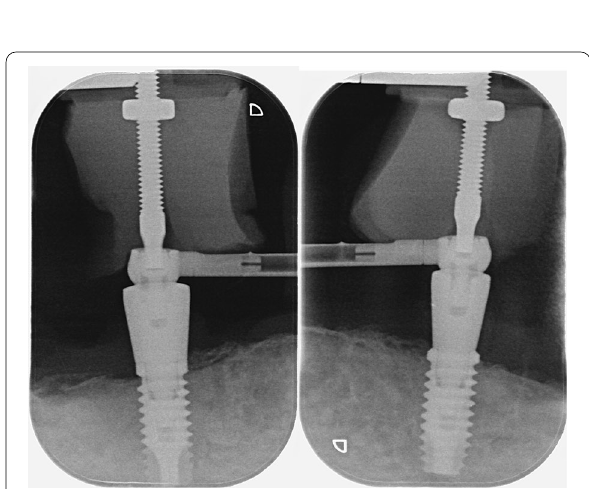
Fig. 5 Exemplary radiograph of the implant group BL‑SIC (SIC invent AG, Basel,